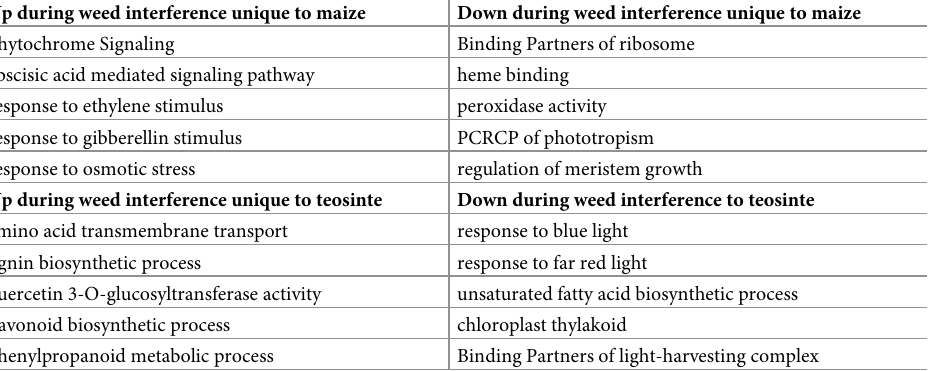
Table 9. Subset of over-represented gene ontologies unique to either maize or teosinte. In these subsets, groups of ontologies that were unique by name, but related in function to ontologies present in the alternate species were